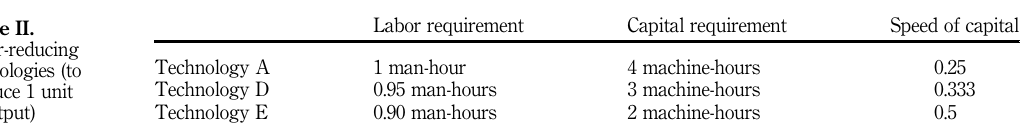
Table II. Labor-reducing technologies (to produce 1 unit of